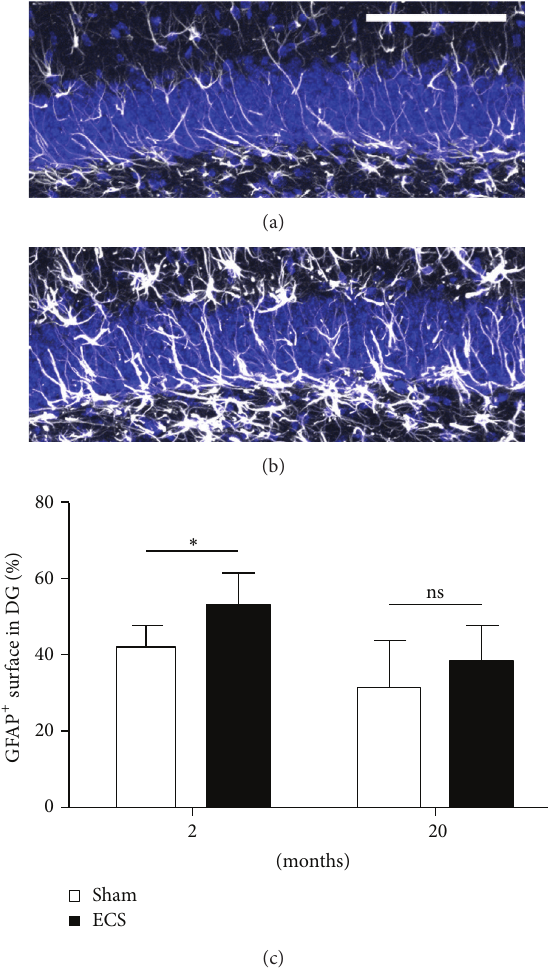
Figure 3: Detection of GFAP in the dentate gyrus of (a) sham- treatedor(b)ECS-treatedmouseofthe2monthsofagecohort,scale bar in (a) 100 𝜇 m. (c) Graph showing percentage of area covered by GFAP-expressing cells in the granular layer of dentate gyrus in 2- and 20-month-old mice following ECS or sham treatment. A two- way ANOVA detected a significant increase of the GFAP expression upon experimental ECS ( 𝑃 = 0.0043 ( ∗∗ )). Bonferroni post hoc test revealed that the significance resulted from differences in the 2-month-old group ( 𝑃 < 0.05